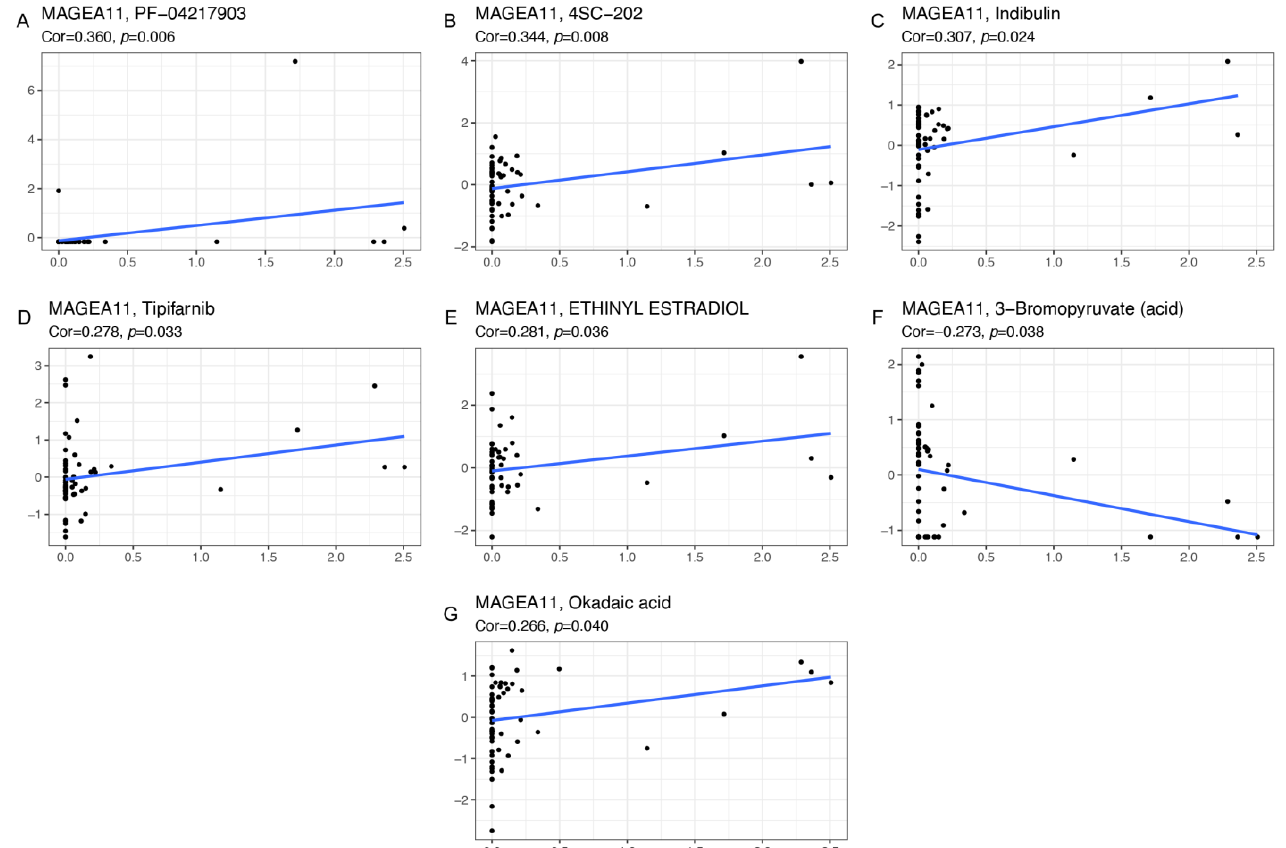
Figure 7. The correlation diagram of gene and drug sensitivity. ( A ) PF-04217903, ( B ) 4SC-202, ( C ) Indibulin, ( D ) Tipifarnib, ( E ) ETHINYL ESTRADIOL, ( F ) 3−Bromopyruvate (acid), and ( G ) Okadaic acid. The x-axis is gene expression, and the y-axis is drug sensitivity.